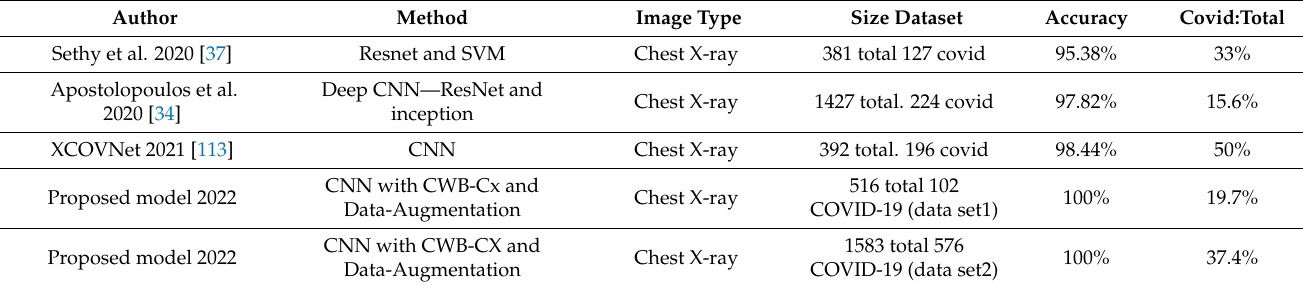
Table 6. Related work comparison only chest X-ray, A.